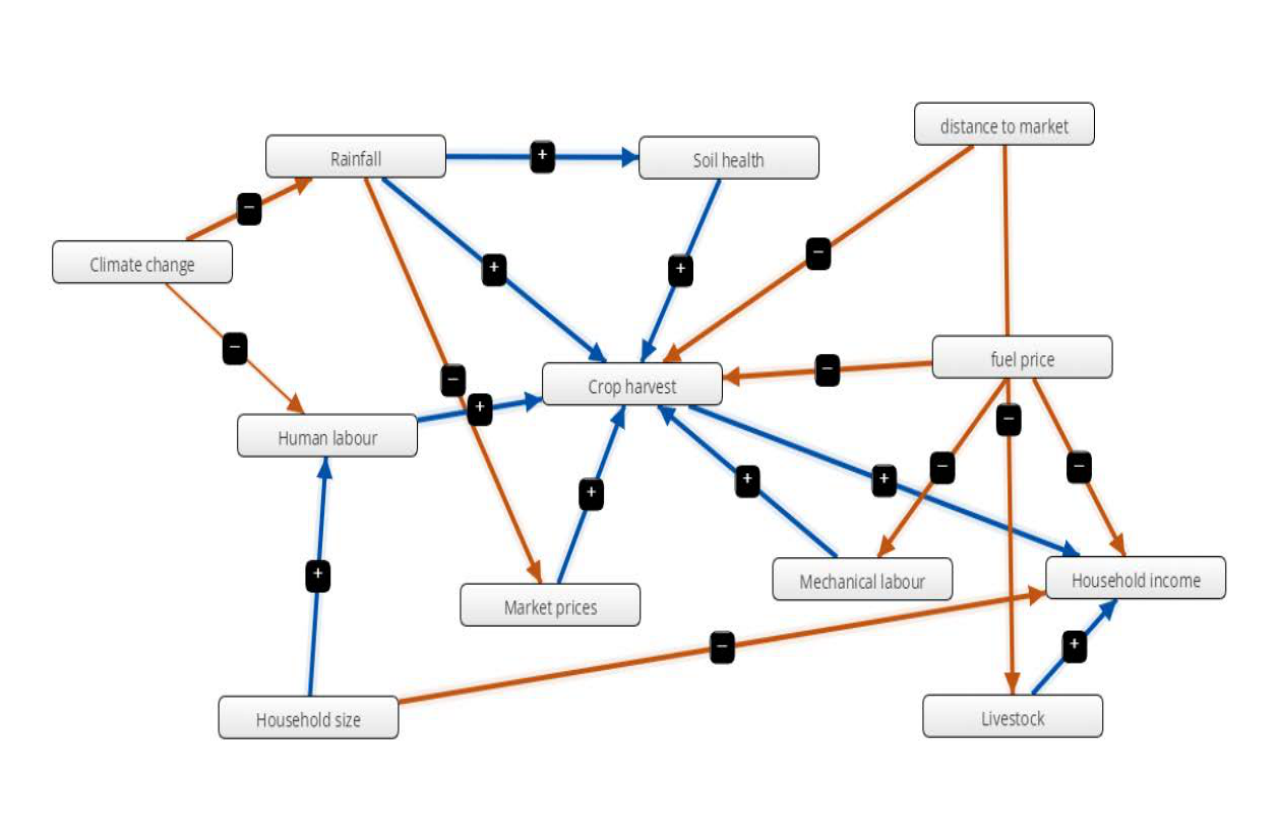
Figure 1: Example of a fuzzy cognitive map. The blocks indicate the important components of the model, the colour and sign of the arrows indicate whether the relationship between components is positive (+) or negative (-) and the thickness of the lines indicates the strength of the